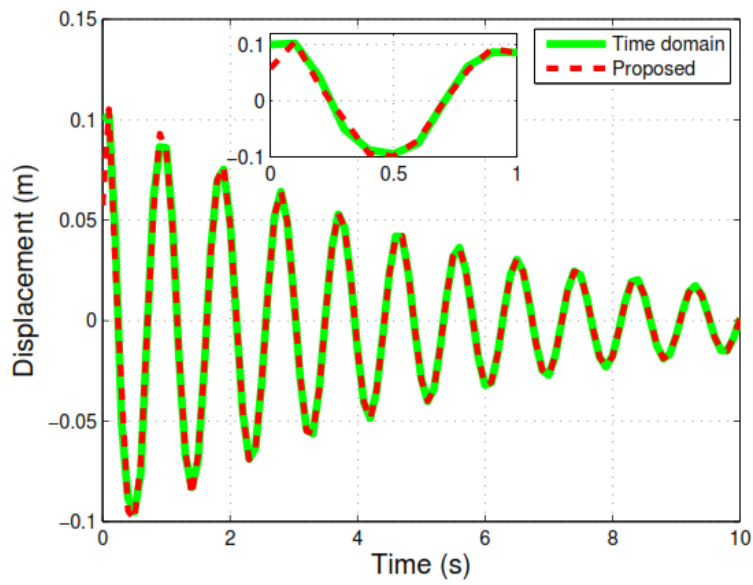
Figure 6. The response comparisons at the top of the tower in the y direction when nonzero displacements and velocity are applied simultaneously.